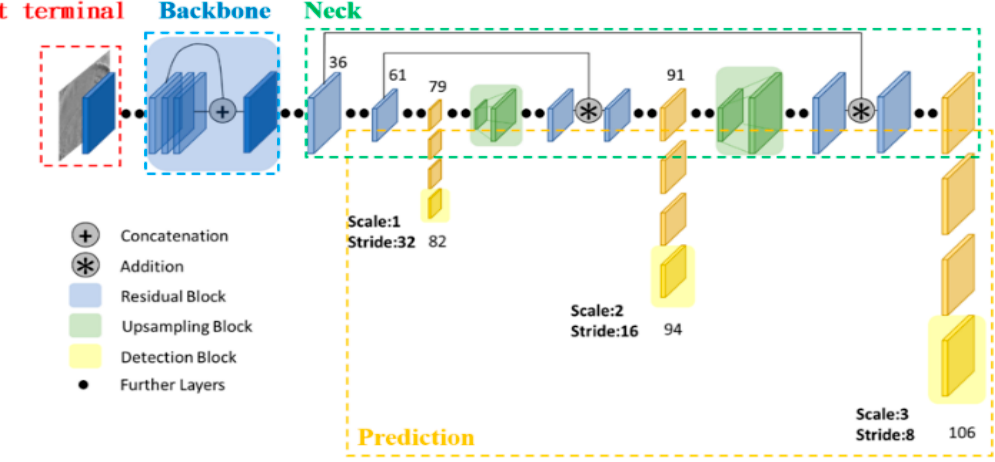
Figure 5. Four main sections of the YOLOv3 architecture [8].